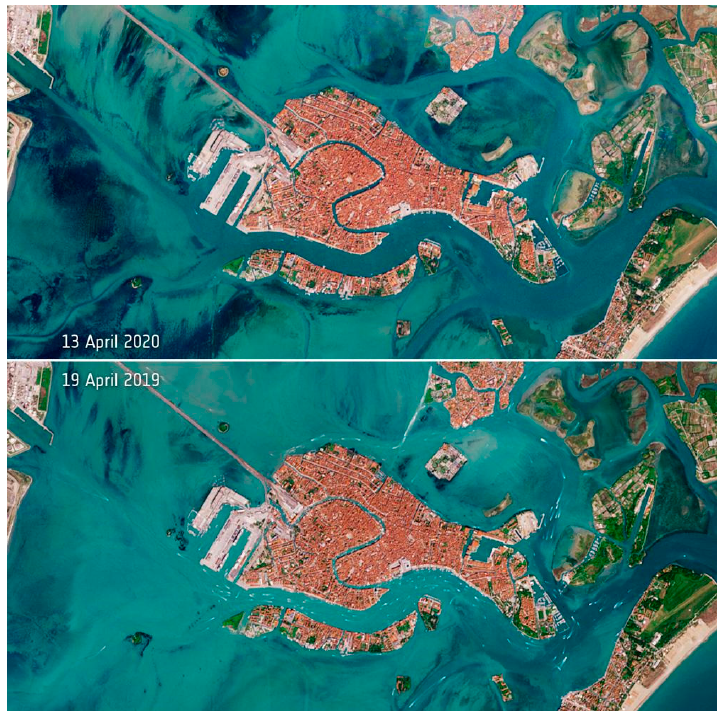
Figure 7. Comparative view of the Venice area between 13 April 2020 vs. 19 April 2019. Satellite images released by the European Space Agency, Copernicus Sentinel-2 mission. Available from http://www.esa.int/ESA_Multimedia/Images/2020/04/Deserted_Venetian_lagoon.